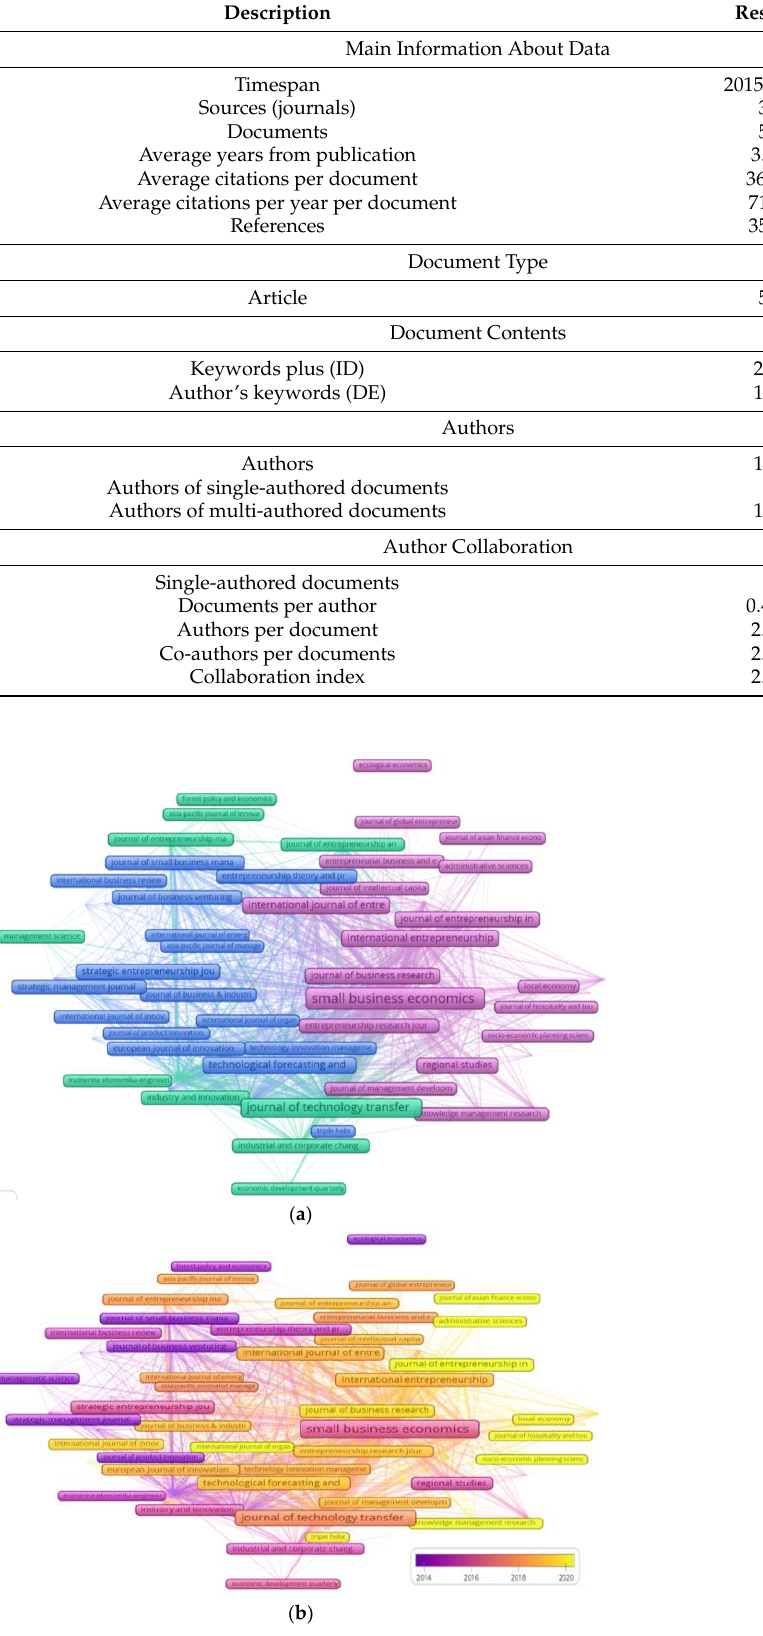
Figure 1. Journals ’ bibliographic coupling (VOSviewer). ( a ) Network visualisation; ( b ) overlay vis-